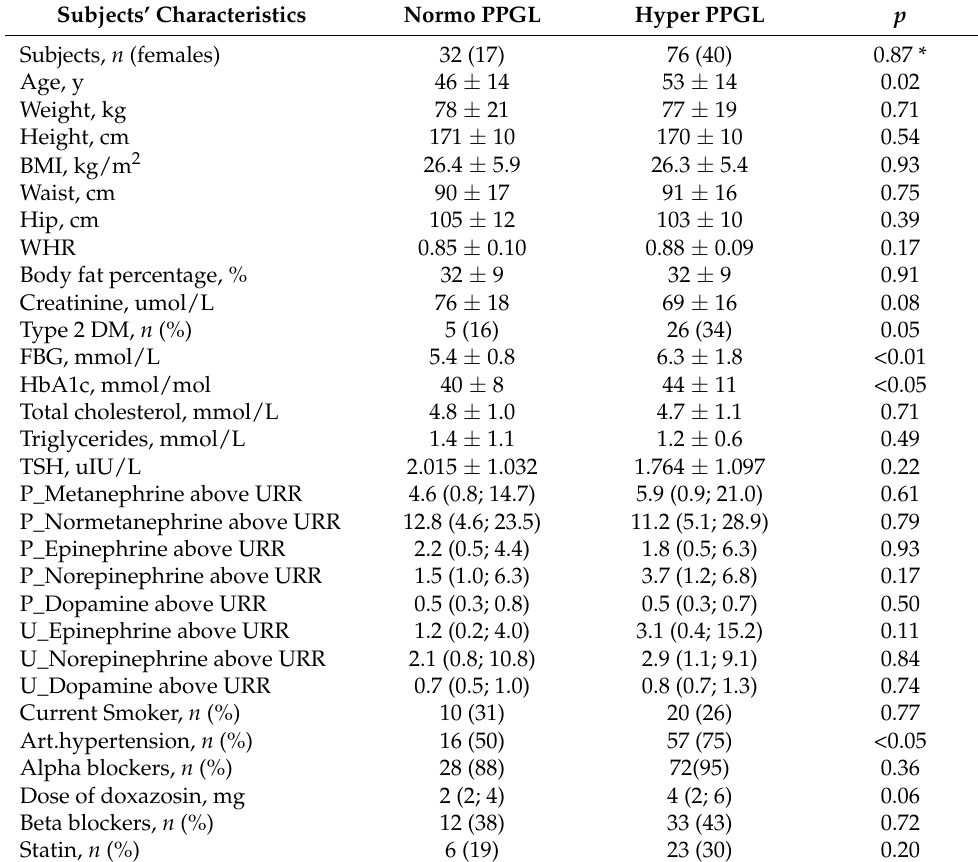
Table 3. Basic subject characteristics according to normo- and hypermetabolism.